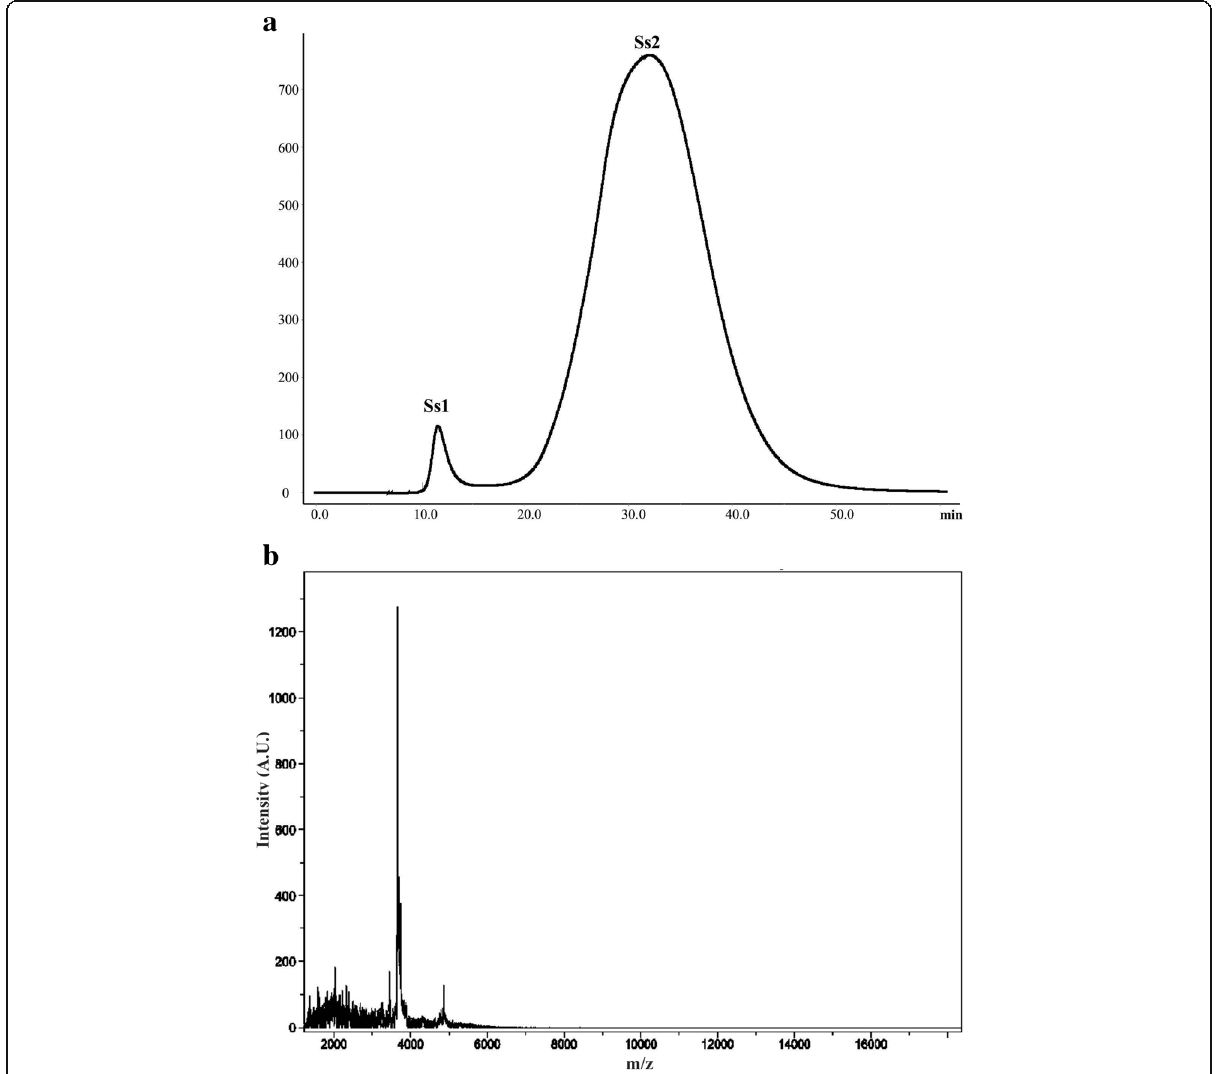
Fig. 8 a S. siderea extract elution profile obtained by FPLC on a Sephadex G-50 column at 280 nm. The column was equilibrated and eluted with 1.6 mM acetic acid at 1 mL/min. b MALDI-TOF of the second fraction (Ss2) after filtration with ultra-centrifugation filters with 10 K